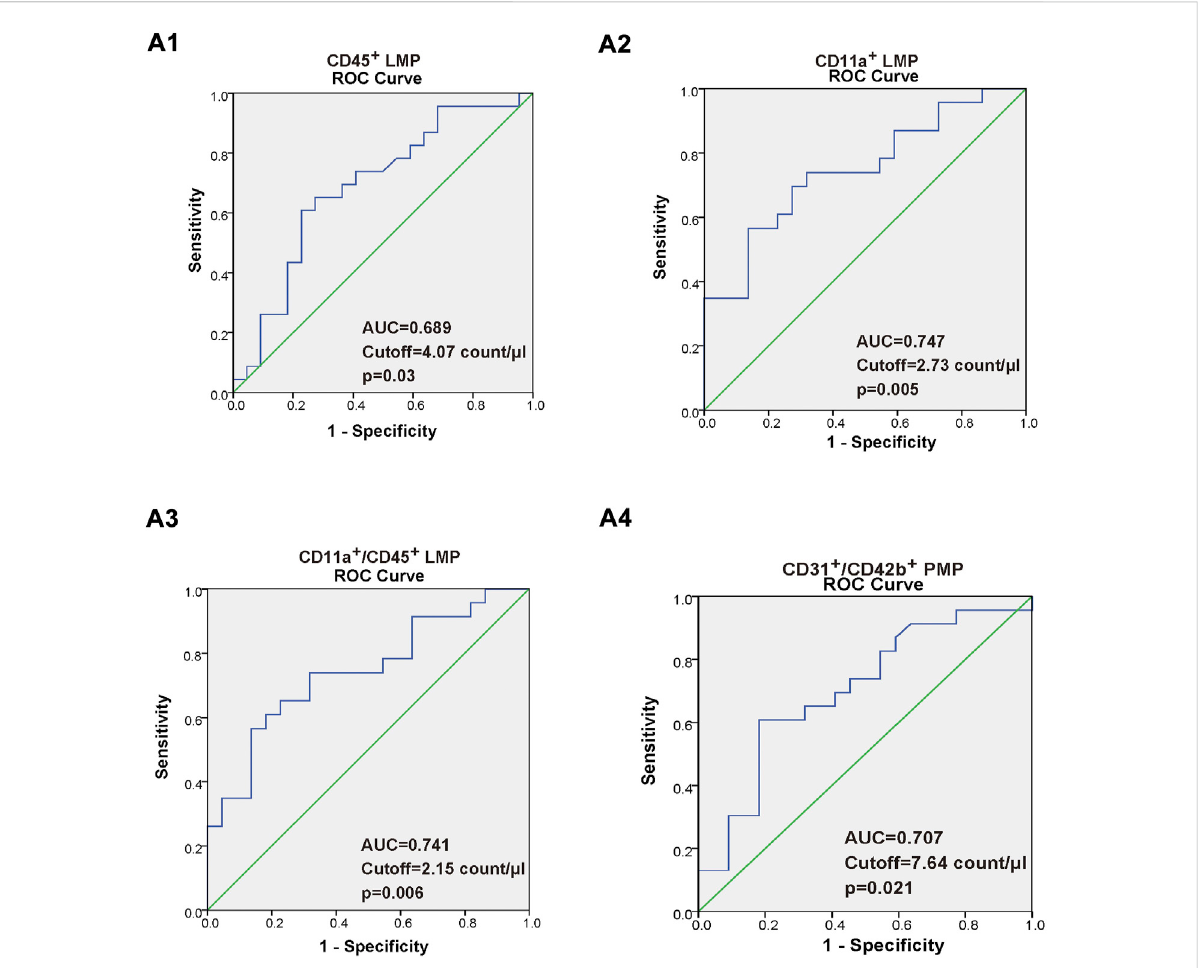
FIGURE 3 (A1 – A4) Receiver operating characteristic (ROC) curve of the CD45 + LMP, CD11a + LMP, CD11a + /CD45 + LMP, and CD31 + /CD42b + PMP. The value of area under the ROC curve (AUC), with a 95% con fi dence interval for diagnostic experiments, ranged within 0.5 – 1. AUC = of 0.5 indicates a completely worthless diagnosis, 0.5 < AUC < 0.7 indicates a lower diagnostic accuracy, 0.7 < AUC < 0.9 indicates a moderate diagnostic accuracy, 0.9 < AUC < 1, indicates a higher diagnostic accuracy, and AUC = of 1, indicates a completely ideal